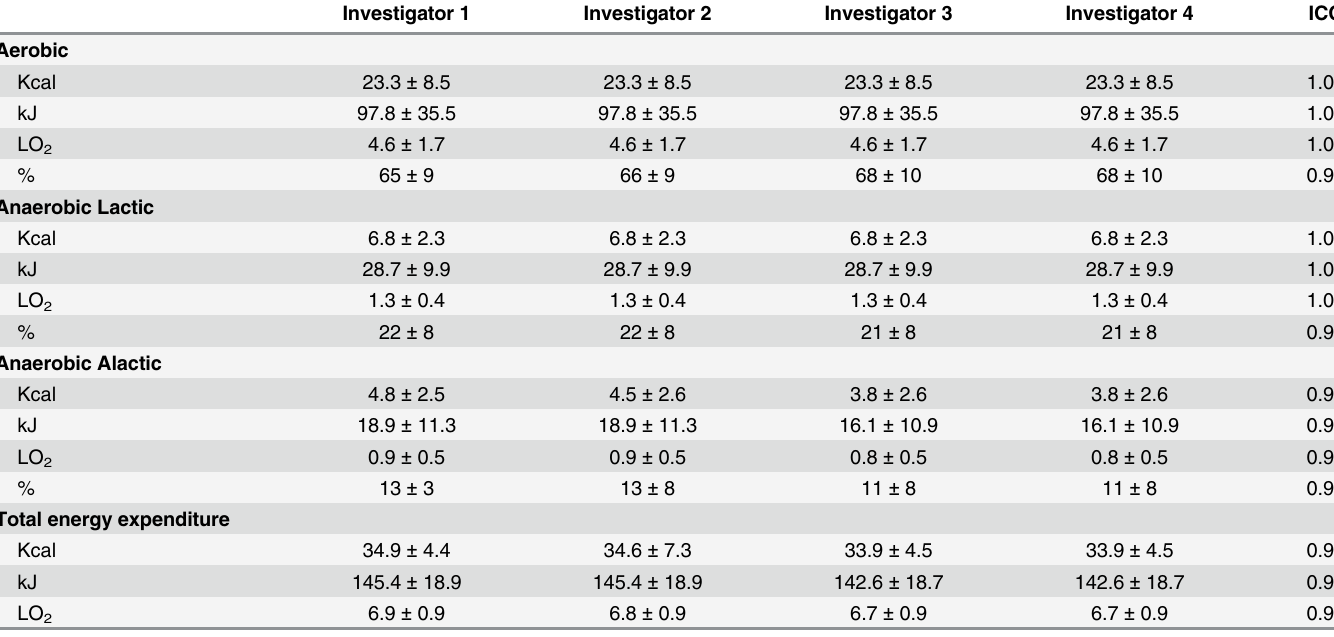
Data are means ± standard deviations. ICC: Intraclass Correlation Coef fi